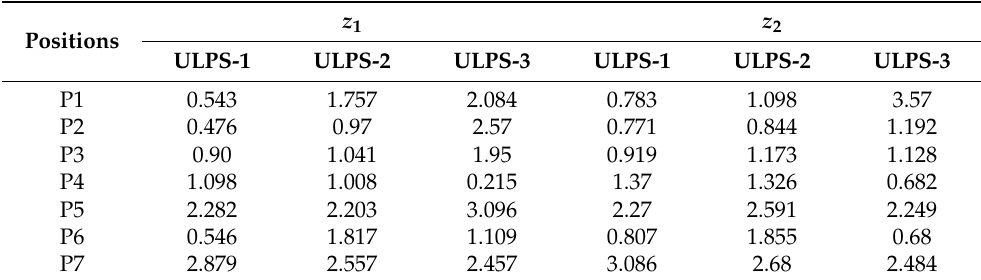
Table 2. Positioning errors (m) in 90% of cases for the considered positions P1–P7 at z 1 = 1.35 m and z 2 = 1.93 m, when the ULPSs operate